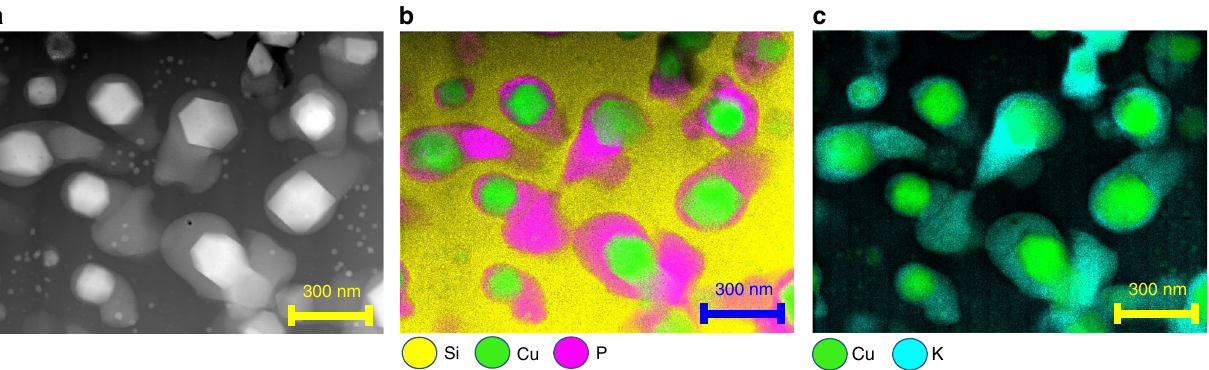
Fig. 3 Elemental mapping of chemical species in microstructure of copper – glass ceramic Energy-dispersive X-ray spectroscopy (EDS) using a scanning transmission electron microscope was used for elemental mapping. a A microstructural view of the copper – glass ceramic highlighting the three phases present. Some smaller cuprite crystals are also observed in the continuous phase. b EDS elemental mapping shows that the high durability, continuous matrix phase is enriched in silicon, the lower durability, discontinuous phase in enriched in phosphorous, and the crystals are composed of copper. c EDS elemental mapping also reveals that the lower durability phase is enriched in potassium. Although boron is a major element in the composition, it was not included in the analysis due to the dif fi culty of measuring light elements via